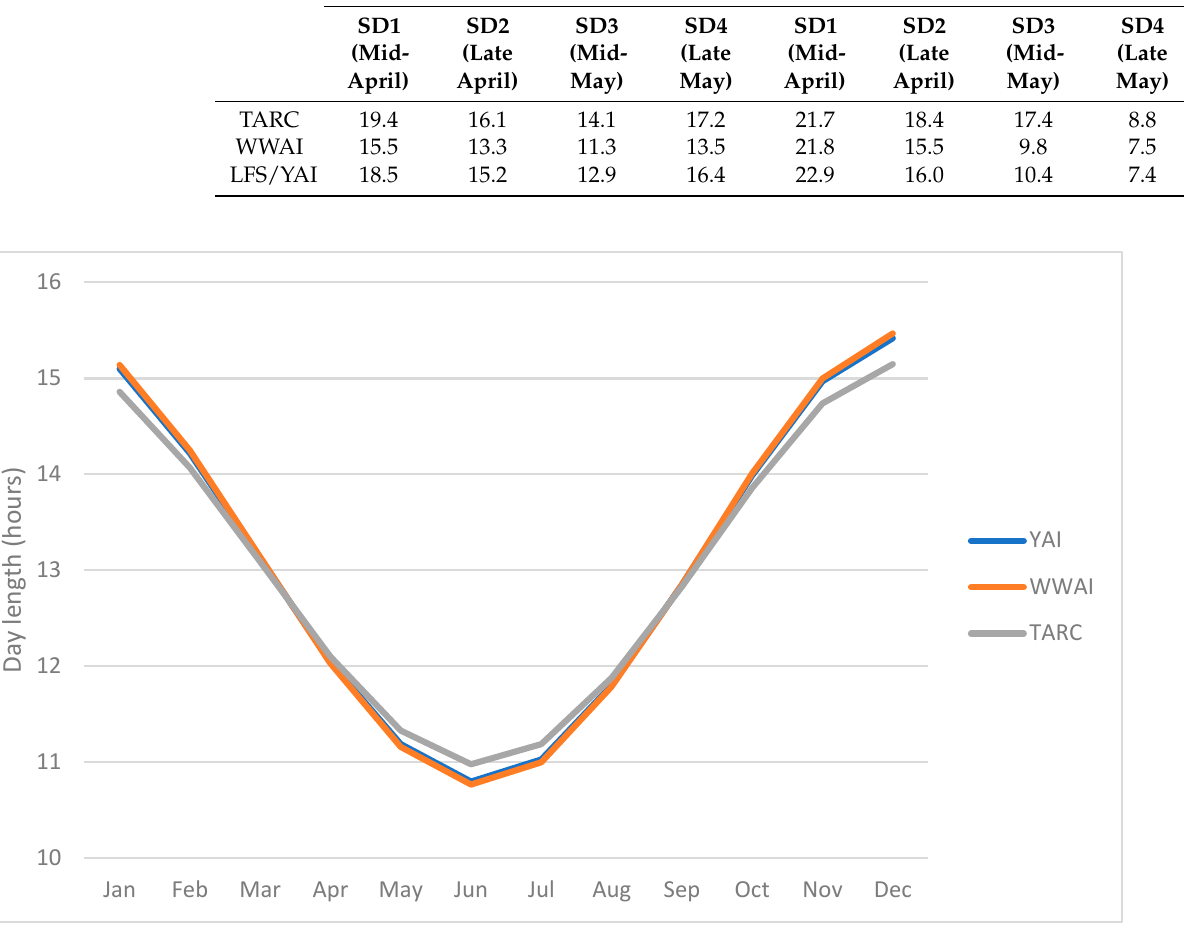
Table 1. Mean daily temperature (°C) for each sowing date (SD) at Trangie Agricultural Research Centre (TARC), Wagga Wagga Agricultural Institute (WWAI), Leeton Field Station (LFS) and Yanco Agricultural Institute (YAI) in 2018 and 2019.